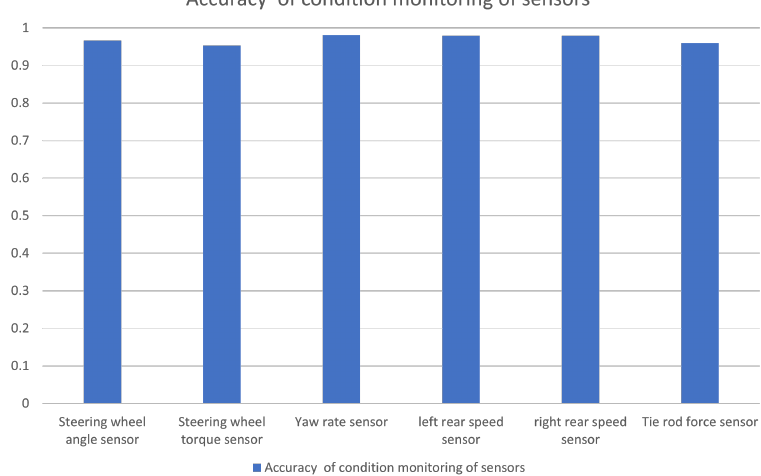
Figure 20. Accuracy of condition monitoring of different sensors.